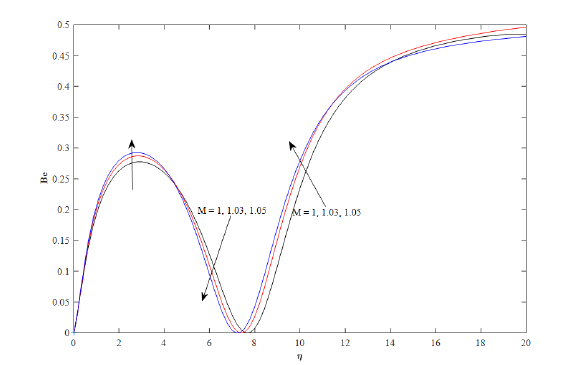
Fig. 8 Bejan number with varying M when Br = 1 , S = 0 . 01 , Q = 1 , X = 2 , Pr = 2 , ω = 1 , K = 0 . 95 .